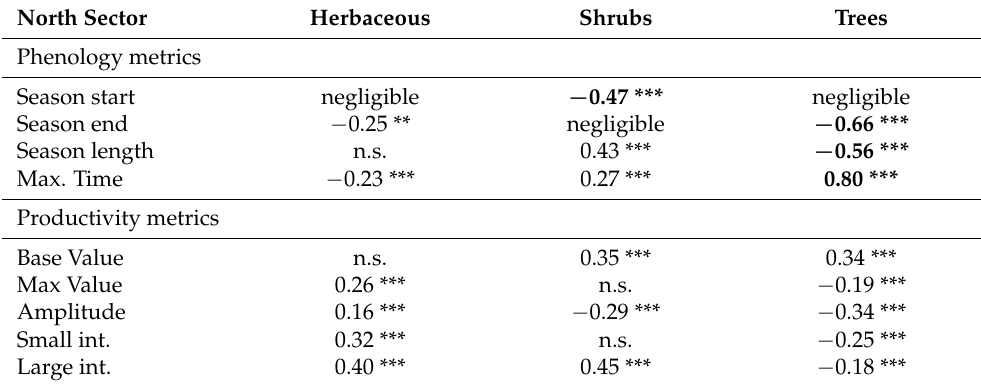
Table 3. Effect sizes (Cliff’s delta values, d) and Wilcoxon Signed-Rank test results of the changes in phenology and productivity metrics between the two time periods in the north sector. A positive delta value is associated with a delay in time, an increase in productivity metrics or in season length in the second time period (and vice-versa for negative values, see text). Wilcoxon Signed-Rank test p -values: ** p < 0.01, *** p < 0.001, n.s.: p > 0.05. Effect sizes are considered negligible if |d| < 0.147 and large (in bold) if |d| >